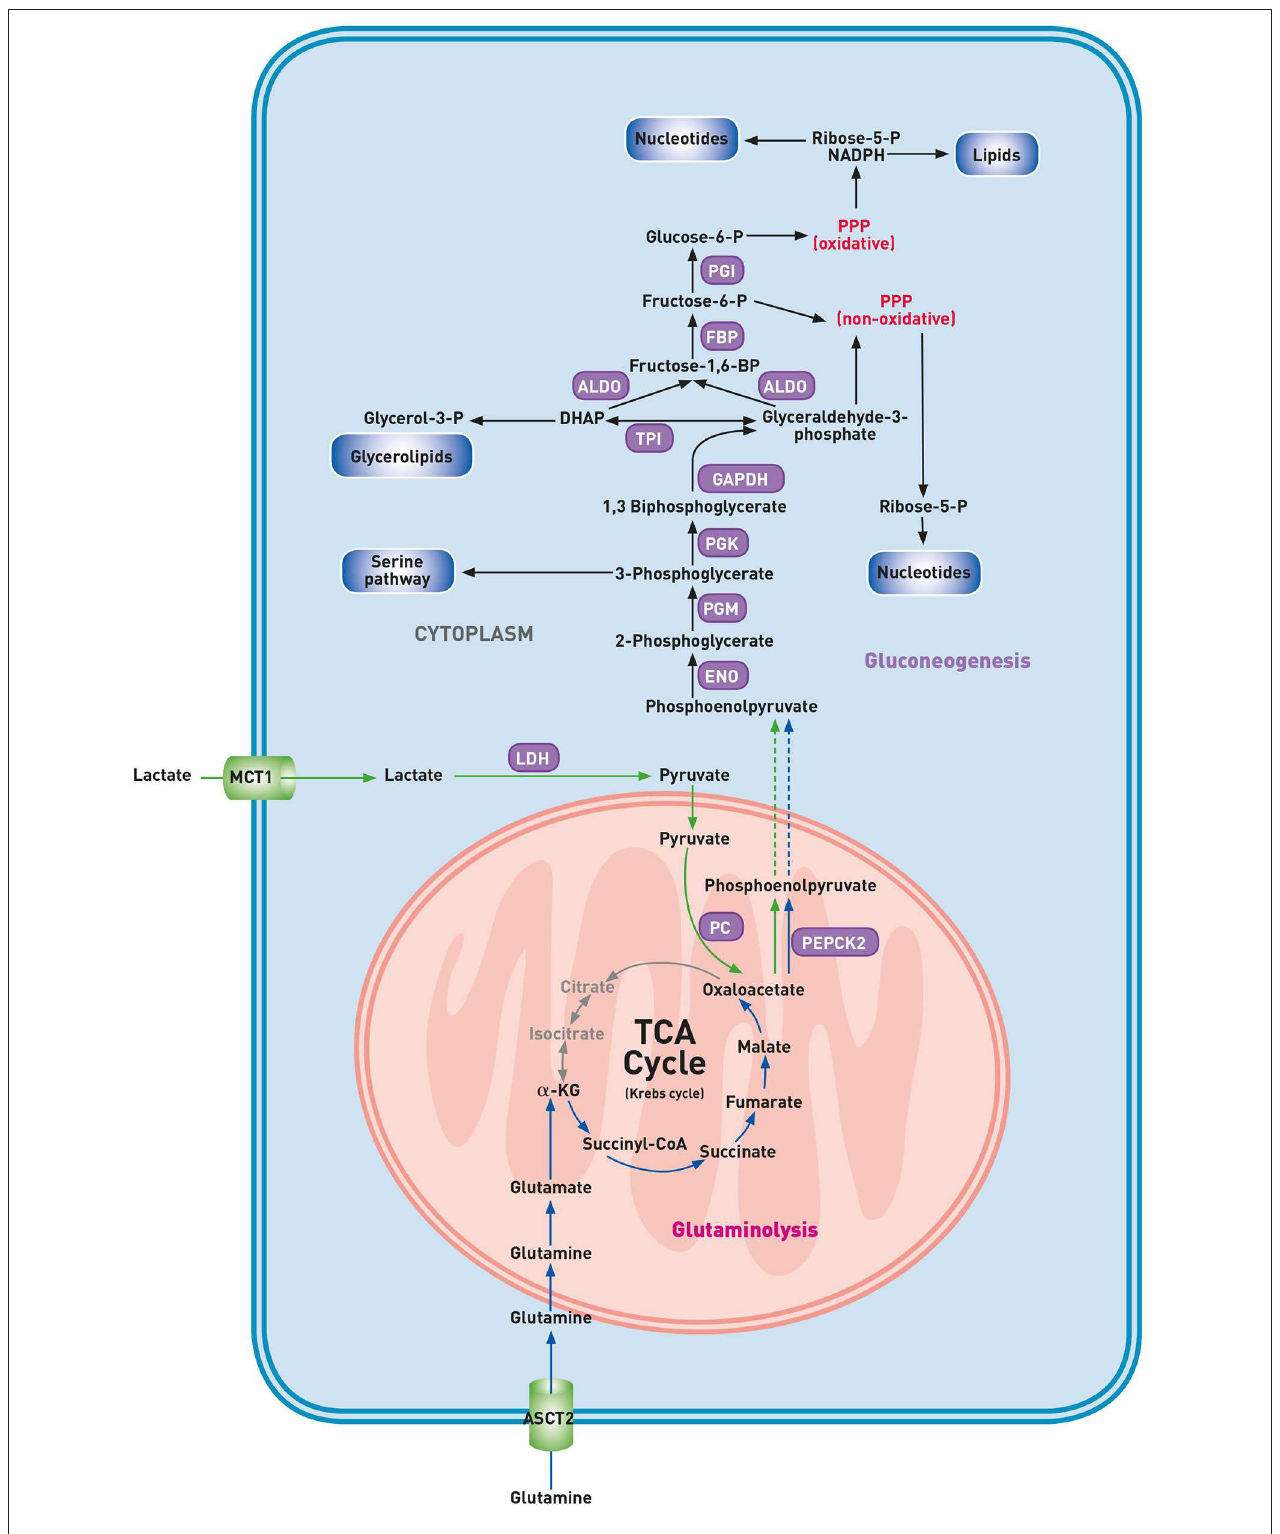
FIGURE 2 | Gluconeogenesis pathway in glucose deprived lung cancer cells. α -KG, α -ketoglutarate; ALDO, aldolase; ASCT2, alanine-serine-cysteine-transporter 2; DHAP, dihydroxyacetone phosphate; ENO, enolase; FBP, fructose bisphosphatase; GAPDH, glyceraldehyde-3-phosphate dehydrogenase; LDH,